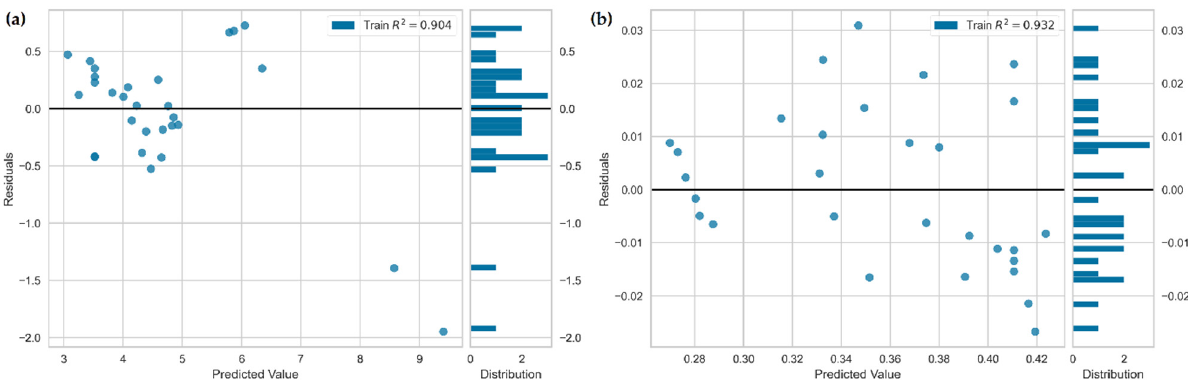
Figure 9. Experimental versus random forest regression predicted ( a ) MRR ( b ) Kerf.